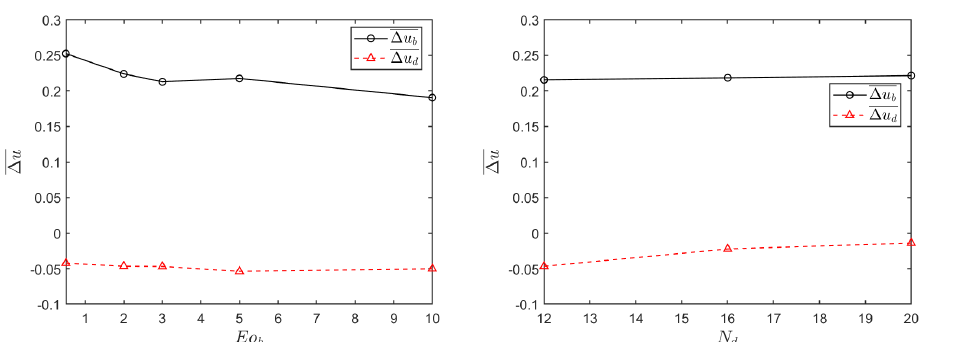
Figure 3. The time-averaged slip velocity versus bubble Eötvös number for N d = 12 ( left ) and versus number of drops ( N d ) for Eo b = 2 ( right ).